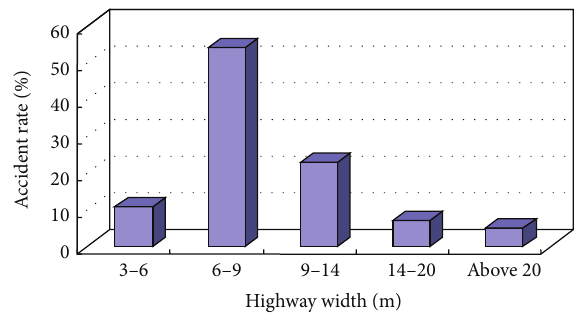
Figure 1: Ratio of accidents according to highway width.